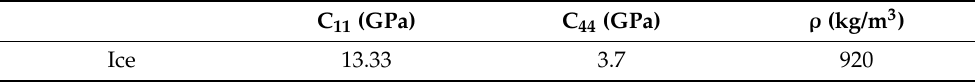
Table 1. Elastic properties of the ice matrix.